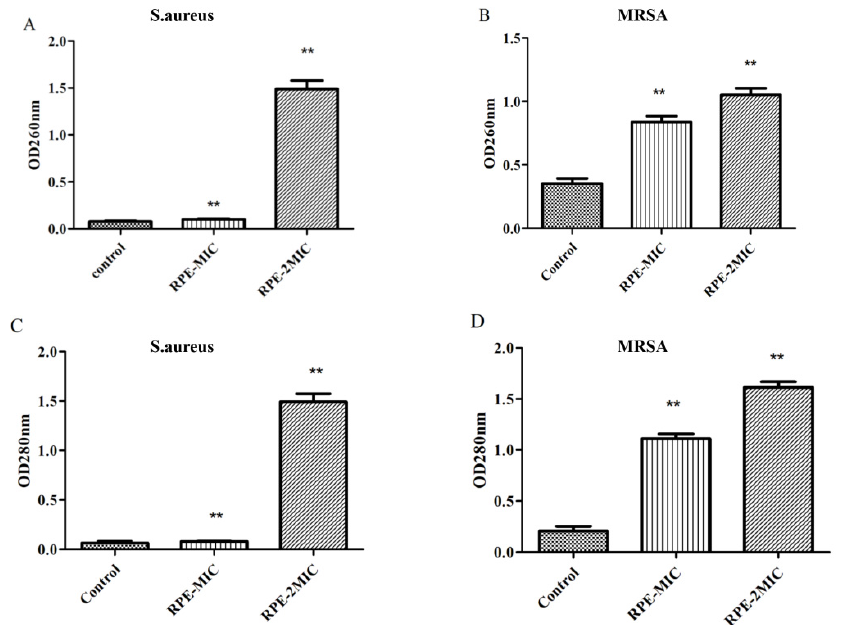
Figure 3. 260 nm absorbance values of S. aureus ( A ) and MRSA ( B ) treated with RPE, and 280 nm absorbance from S. aureus ( C ) and MRSA ( D ) treated with RPE. All data are presented as mean values ± SD, and n = 3 in each group. ** p < 0.01, vs. the solvent control.